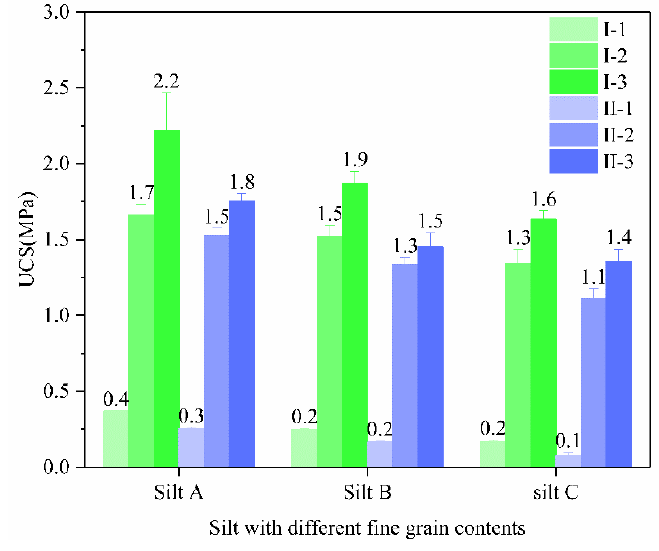
Figure 12. Effects of different fine particle content on unconfined compressive strength.